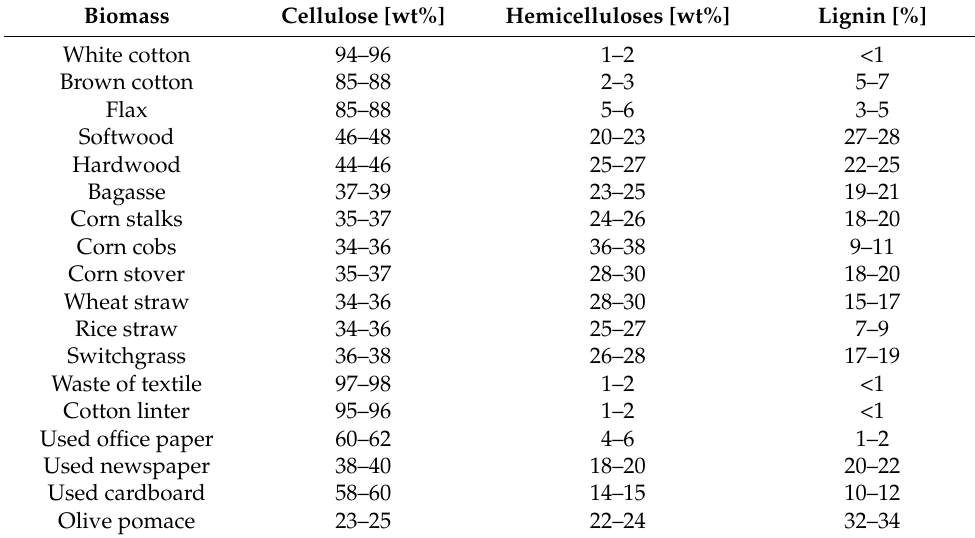
Table 2. Chemical composition of dry plant biomass and dry waste biomass